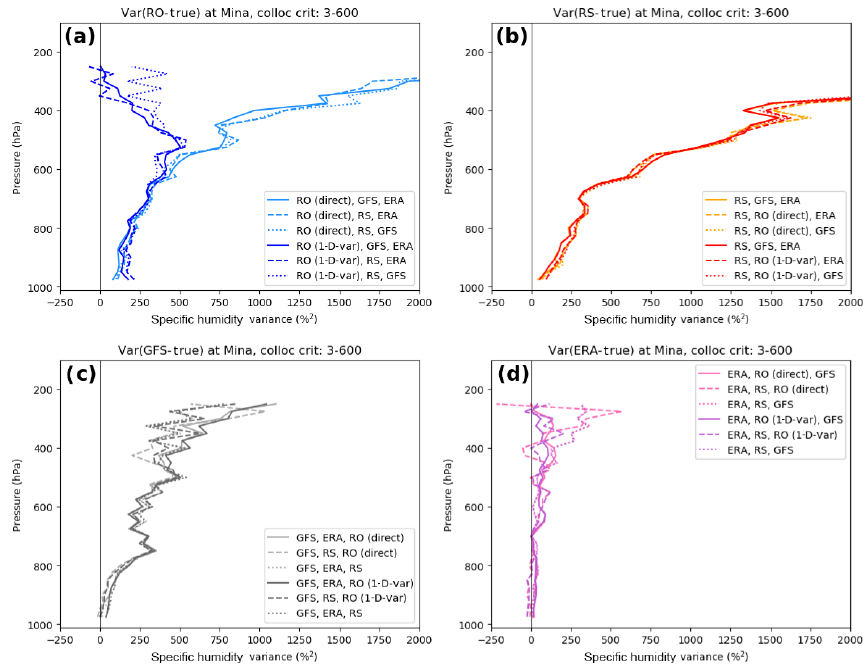
Figure 6. Estimated error variances (percent squared) of specific humidity at Mina: (a) RO, (b) RS, (c) GFS, and (d) ERA.